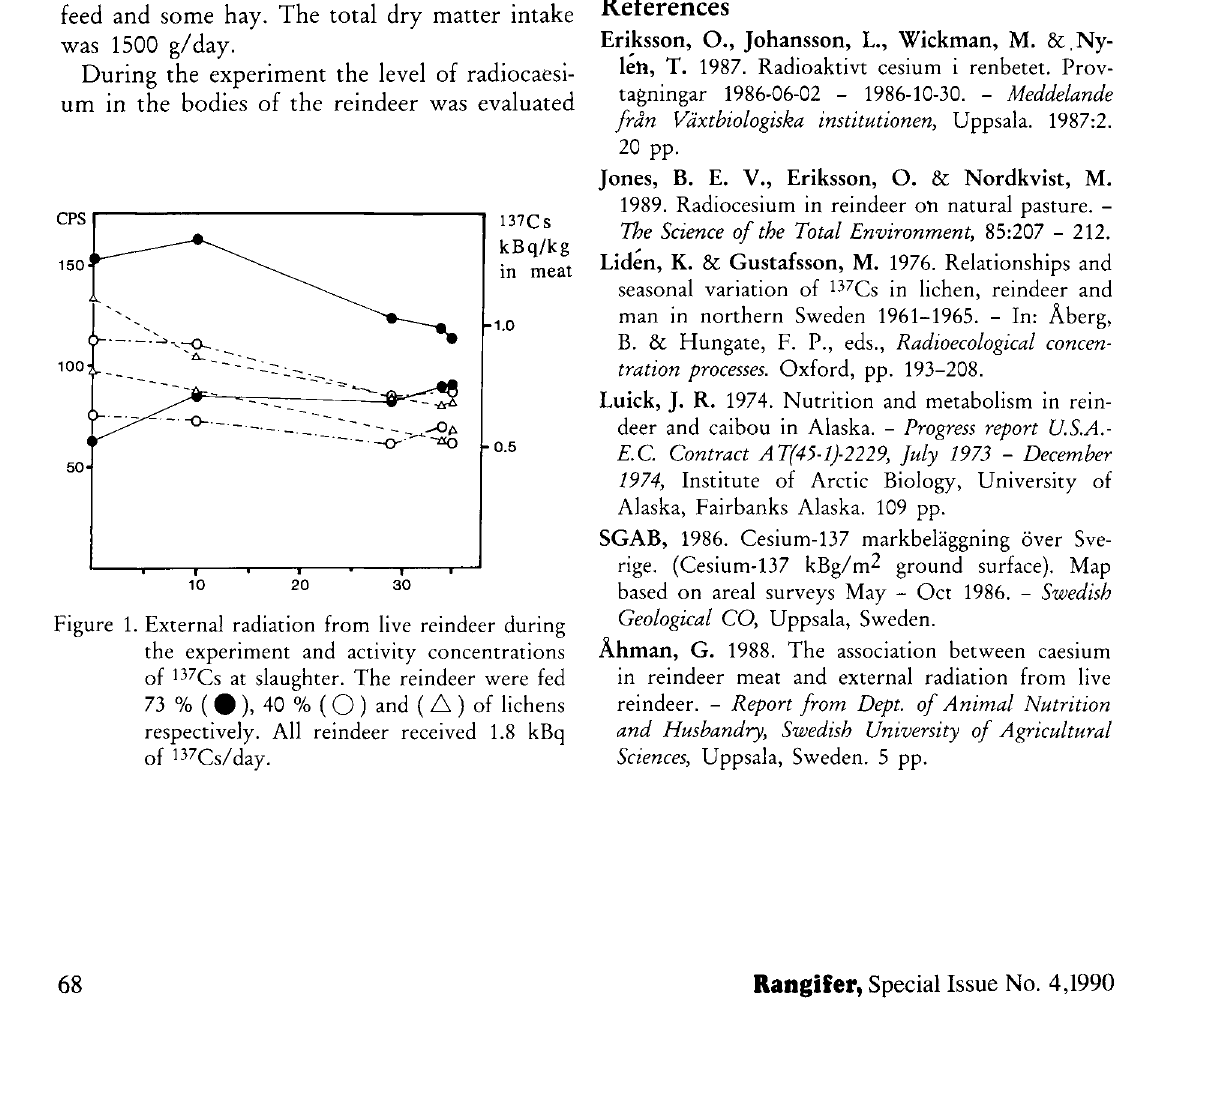
Figure 1. External radiation from live reindeer during the experiment and activity concentrations of 137 Cs at slaughter. The reindeer were fed 73 % ( • ), 40 % ( O ) and ( A ) of lichens respectively. All reindeer received 1.8 kBq of i 37